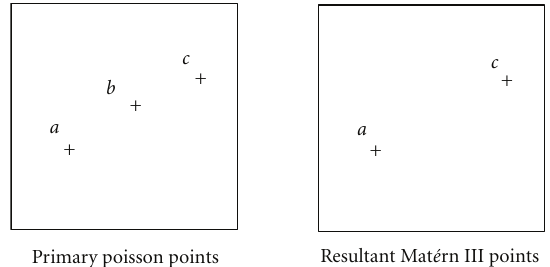
Figure 1: Simple example of Mat´ern Type III repulsive point